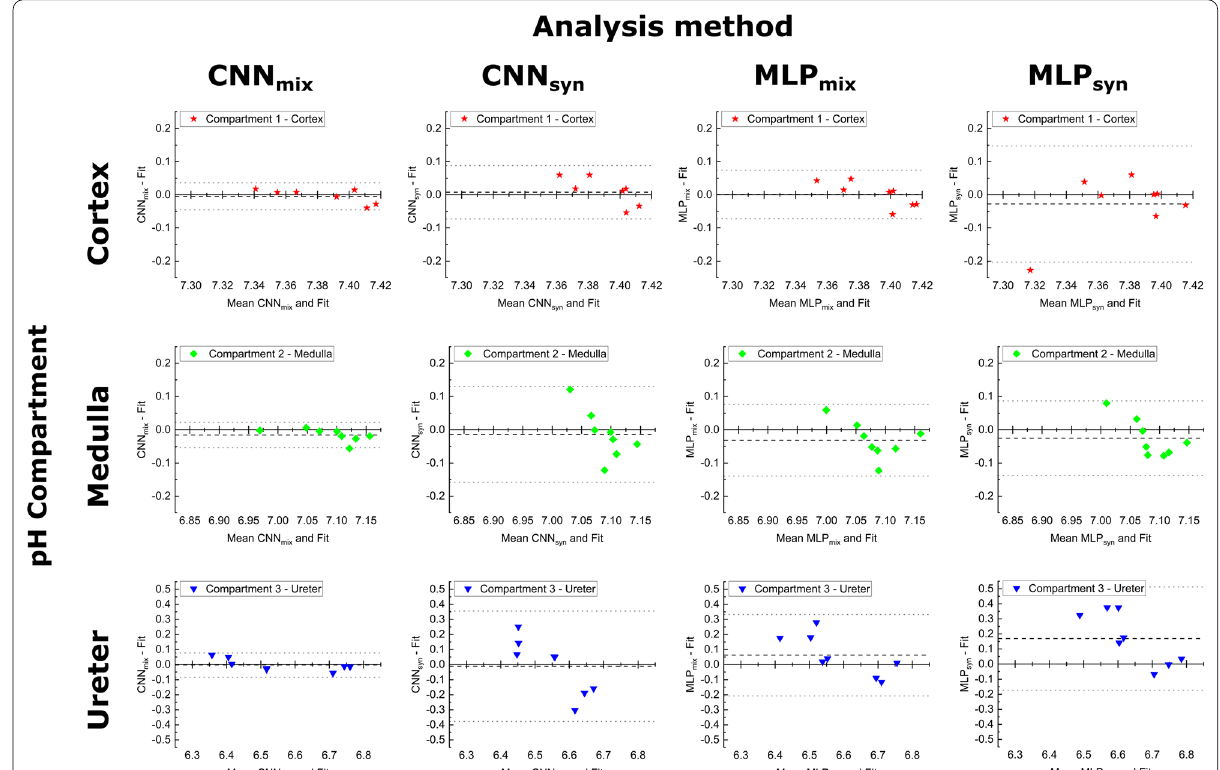
Fig. 6 Conventional Bland–Altman plots showing the difference between predicted and conventionally fitted pH e values from spectra of hyperpolarized 13 C acquisitions on mice kidney plotted against the mean pH e from both analysis methods. Black dashed lines indicate the mean difference and grey dotted lines indicate the 95% confidence interval for this